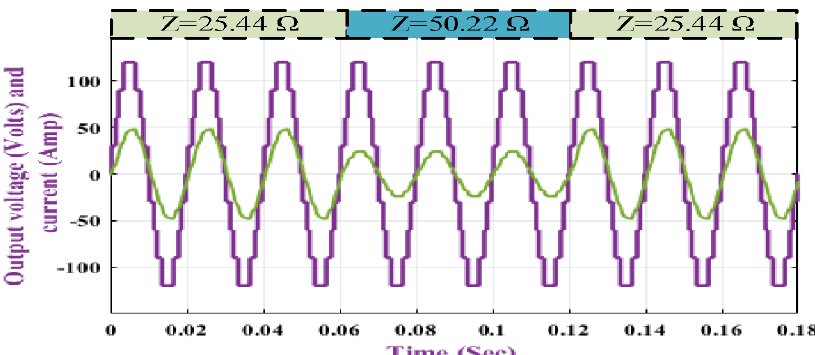
Figure 19. Dynamical RL load in nine-level changing from 25.44 Ω–50.22Ω– 25.44 Ω. The current waveform is multiplied by 10.